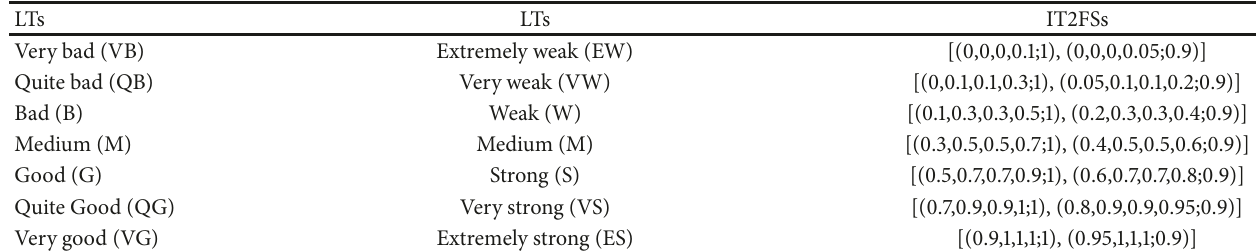
Table 1: Linguistic terms and their corresponding IT2FSs [35,